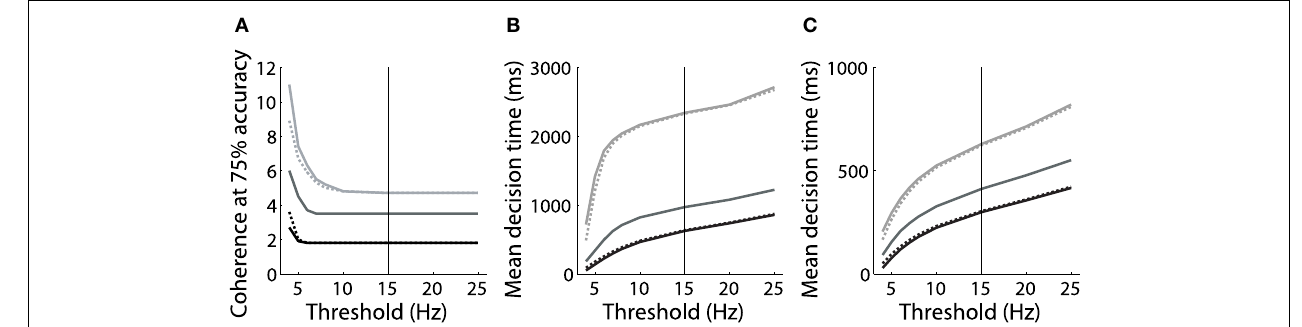
little difference to accuracy, i.e., the solid and dotted curves are similar for speed and accuracy conditions, and do not overlay the neutral curve. (B,C) Mean decision times over all trials for coherence c = 1% (B) and c = 32% (C) . Conventions are the same as in (A) . Adjusting the threshold by (cid:3) ns and (cid:3) na makes little difference to decision times, regardless of the threshold chosen. The solid vertical line in each panel indicates the threshold used by Wong and Wang